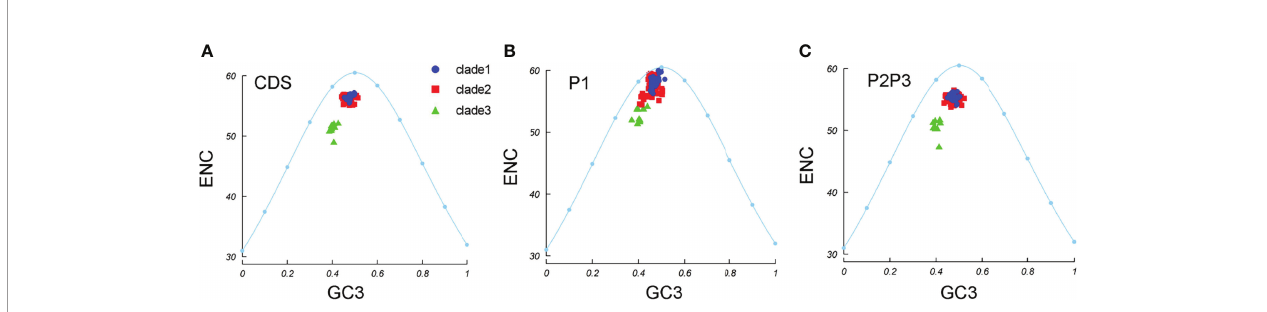
FIGURE 6 | ENC-GC3 plots. The curve indicates the expected codon usage if GC compositional constraints alone account for the codon usage bias. (A) coding sequences, (B) P1 region, (C) P2P3 region. The blue dots, red squares, and green triangles indicate clade 1, clade 2 and clade